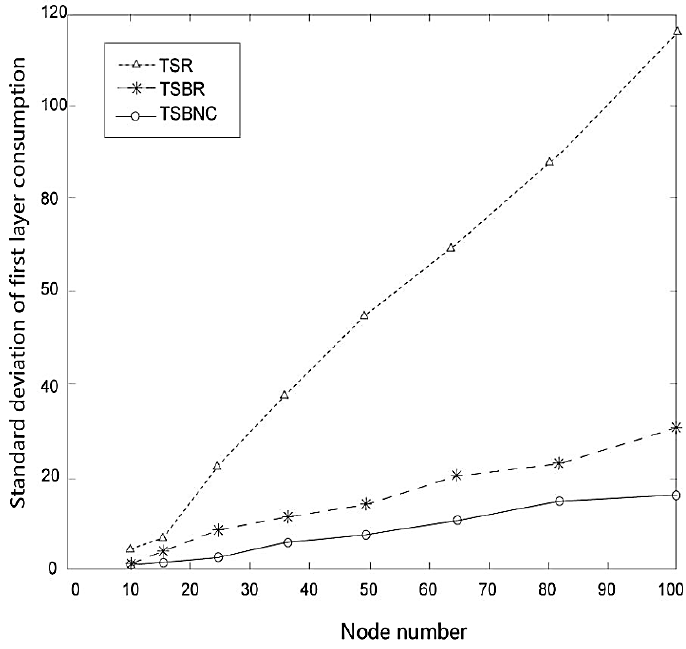
Figure 10. Standard deviation of first layer consumption.